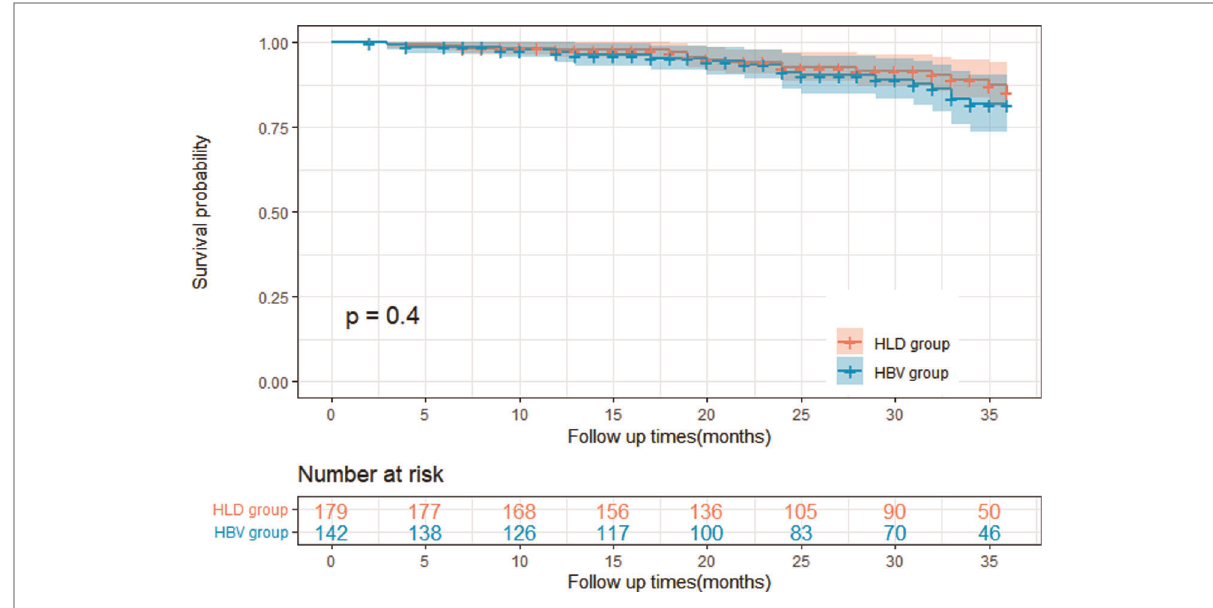
FIGURE 4 Comparison of mortality between two groups after 36 months of